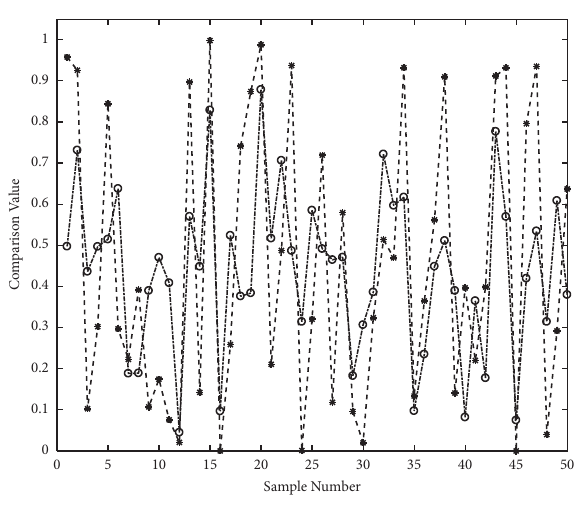
Figure 8: ELM prediction.